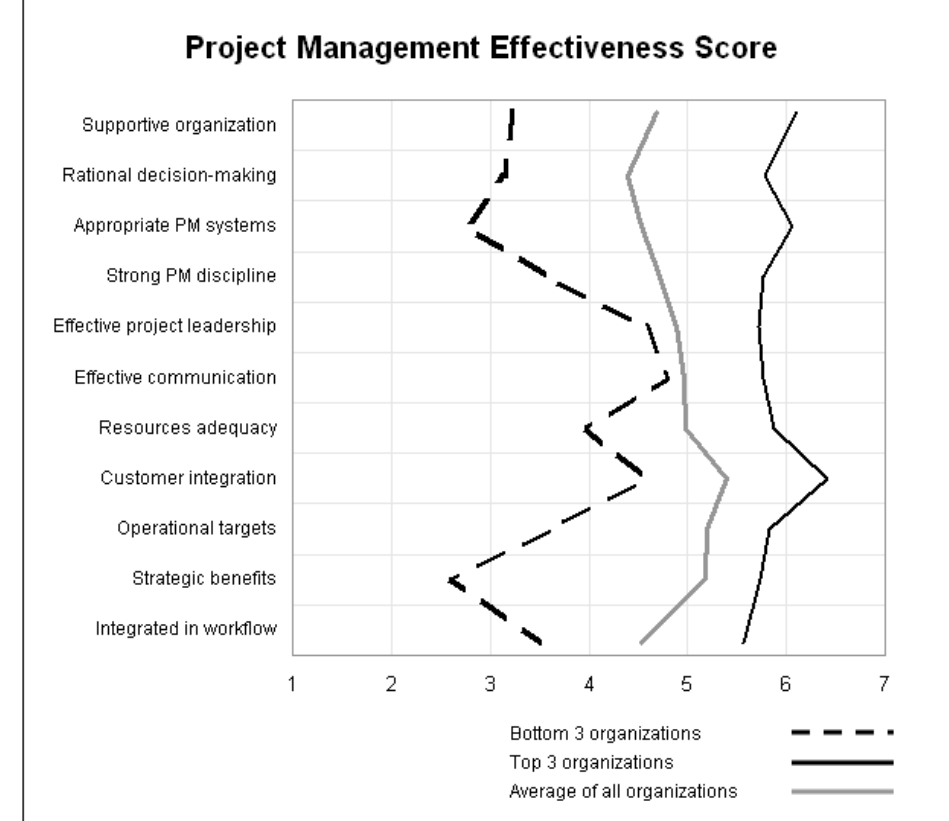
Figure 1: Average scores on project management